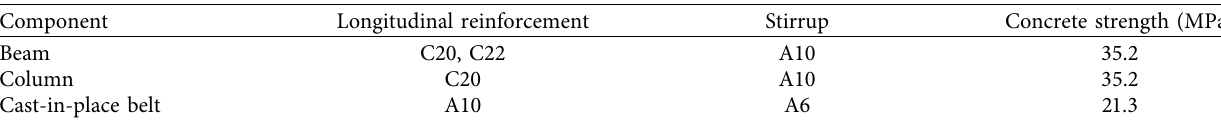
Figure 4: Design of specimens (mm) and instrumentation arrangement. (a) W-1. (b) W-2. (c) W-3. (d) W-4. Table 3: Type of